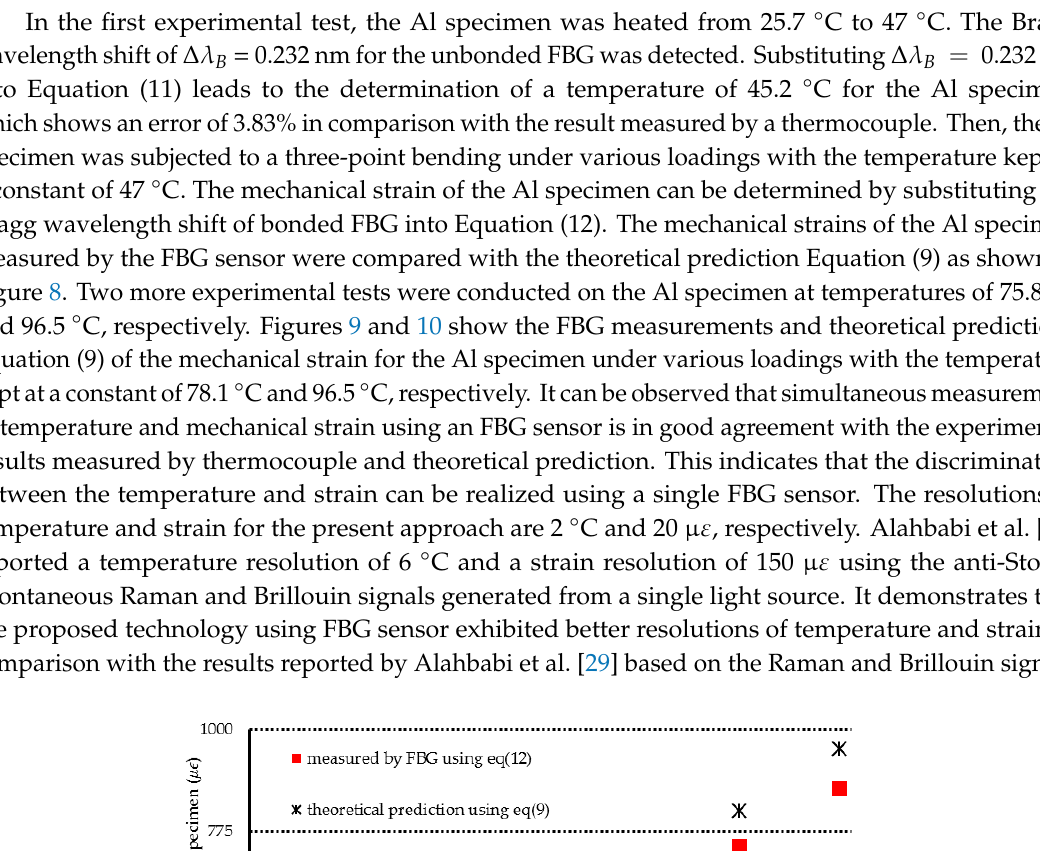
Figure 8. Mechanical strain of the Al specimen subjected to three-point bending with various loadings at a temperature of 47 °C. Figure 7. Optical spectrum reflected from the unbonded and bonded FBG subjected to a mechanical loading of 157 N at a temperature of 47 °C.